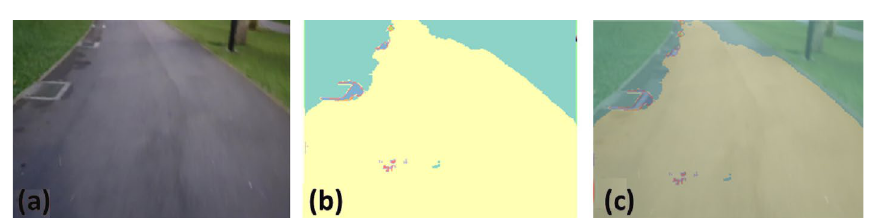
Figure 33. Unet segmentation results.